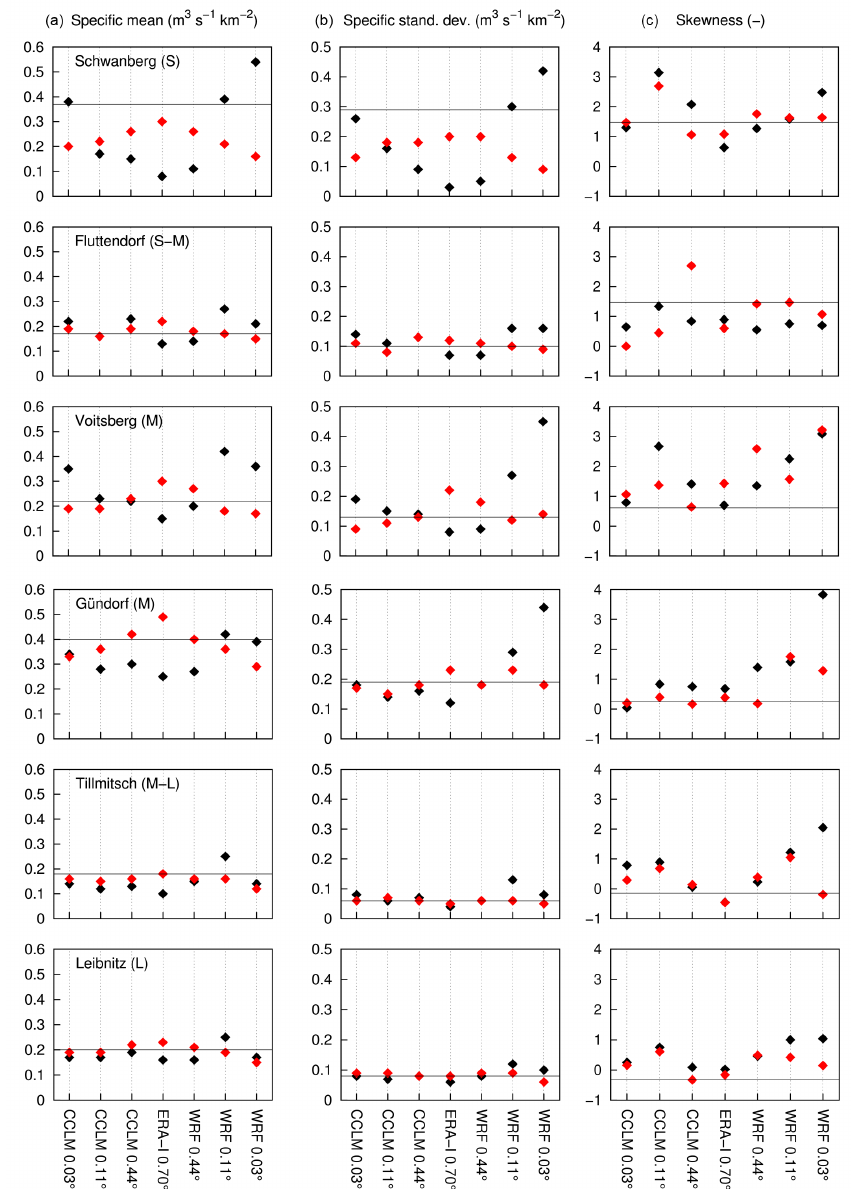
Figure 16. Statistical measures of maximum annual flood peak distribution evolving the different model runs. (a) Specific mean, (b) specific standard deviation and (c) skewness. Black: raw RCM data; red: bias-corrected RCM data as input. Black horizontal line denotes the values from the observed flood peak